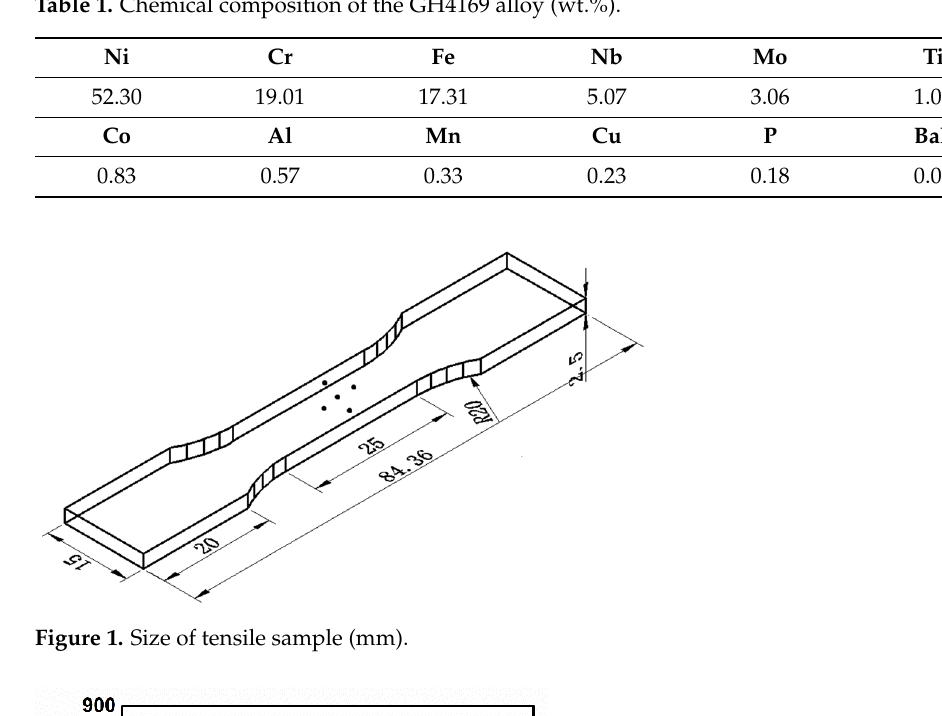
Table 1. Chemical composition of the GH4169 alloy (wt.%).